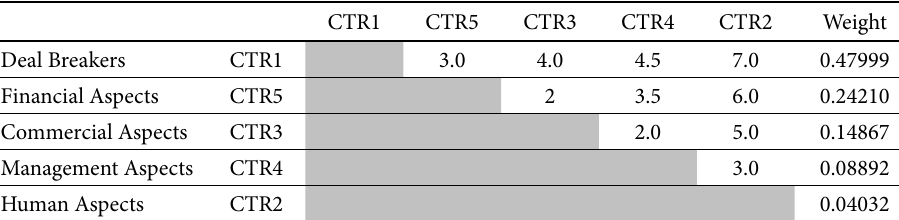
Table 4. Matrix of pairwise comparisons and